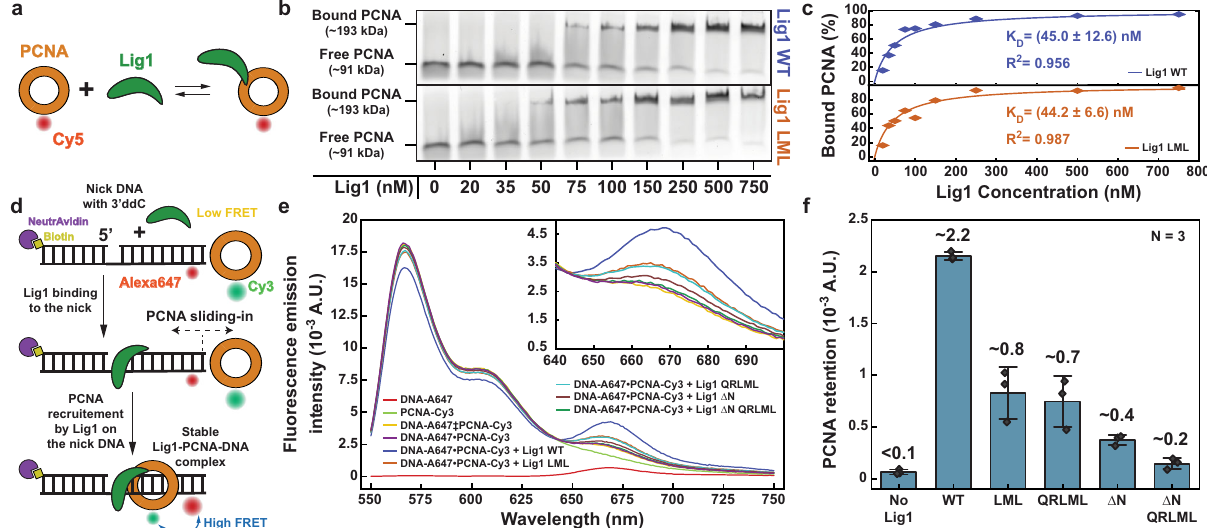
Fig. 3 | Biochemical assays ofLig1 binding to PCNA in absence and presence of DNA. a Schematics of the experiment shown in panel ( b ). b Protein – protein EMSA was used to monitor the binding of WT_Lig1 and LML_Lig1 to Cy5-labeled PCNA (1nM) in solution in the absence of DNA. c Quanti fi cation of the EMSA data pre- sented in panel ( b ). The experimental data points were fi tted to quadratic depen- denciesasdescribedin “ Methods ” . d Schematicsoftheexperimentshowninpanel ( e ). e Emission spectra of DNA-Alexa Fluor 647 and PCNA-Cy3 in the absence and presence of WT_Lig1 or Lig1 variants. DNA-Alexa Fluor 647 (500nM) was blocked withNeutrAvidin(1 μ M)attheendofthedownstreamarmtopreventPCNAsliding- in from that end and to allow for PCNA sliding-in only through the 3 ’ duplex arm. The nicked DNA contained a 3 ’ ddC to prevent ligation. PCNA-Cy3 (500nM; 3:1=Cy3:PCNA) was then added. The direct sum ( ‡ ) of PCNA-Cy3 and DNA-Alexa